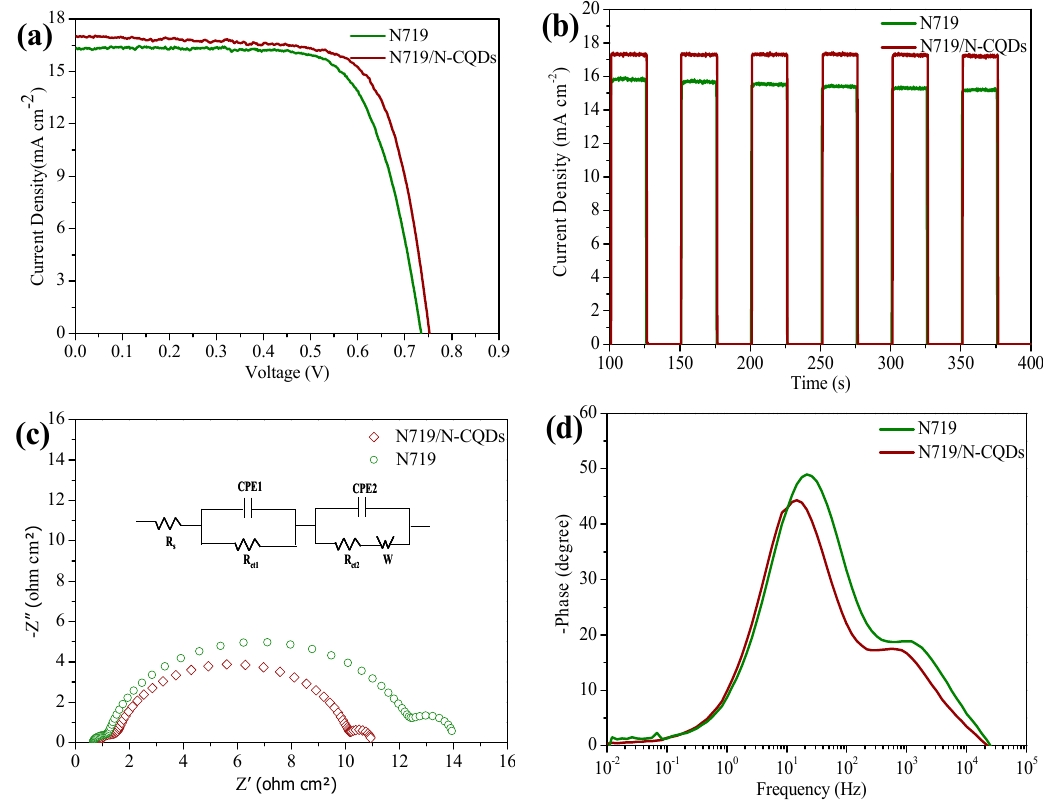
Figure 6. ( a ) Characteristic J – V curves for the solar cells; ( b ) The on-off switches for an optimized solar cells with or without N-CQDs. ( c ) Nyquistand. ( d ) Bode EIS phase plots of the solar cells. The insert presents the equivalent circuit. Table 2. Photovoltaic parameters of co-sensitized solar cell. Sample